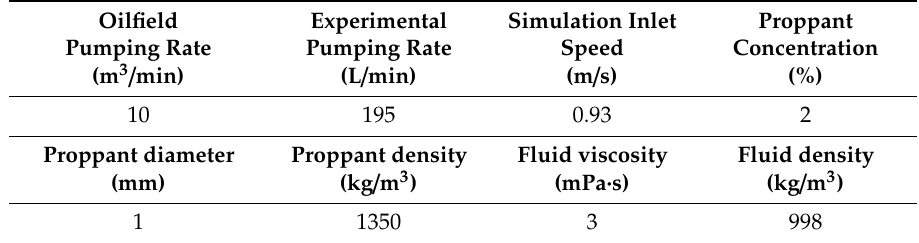
Table 1. Experimental and numerical simulation parameters.